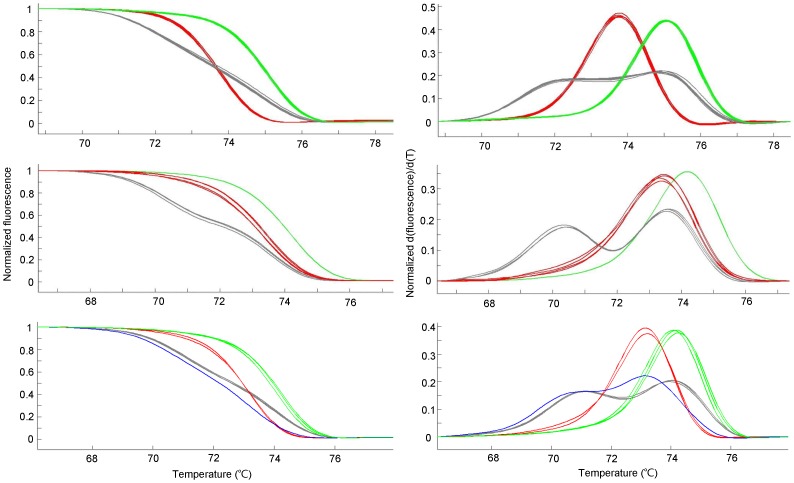
Representative high resolution melting curves for pummelo SNPs.The left and the right panels were melting curves and derivative melting curves respectively. Red and green curves were homozygous amplicons with low and high melting temperatures, respectively. Gray and blue curves represent heterozygotes. Top panels: melting curves of an A/G SNP (chr1_20043485A/G). Middle panels: melting curves of an A/T SNP (chr1_25991020A/T). Bottom panels: melting curves of an A/G SNP (chr4_18094735A/G); note the two different heterozygotes with different melting curves, the normal heterozygote (referred as He1) as shown in gray and the abnormal heterozygote (referred to as He2 that probably contained a primer-template mismatch) in blue.